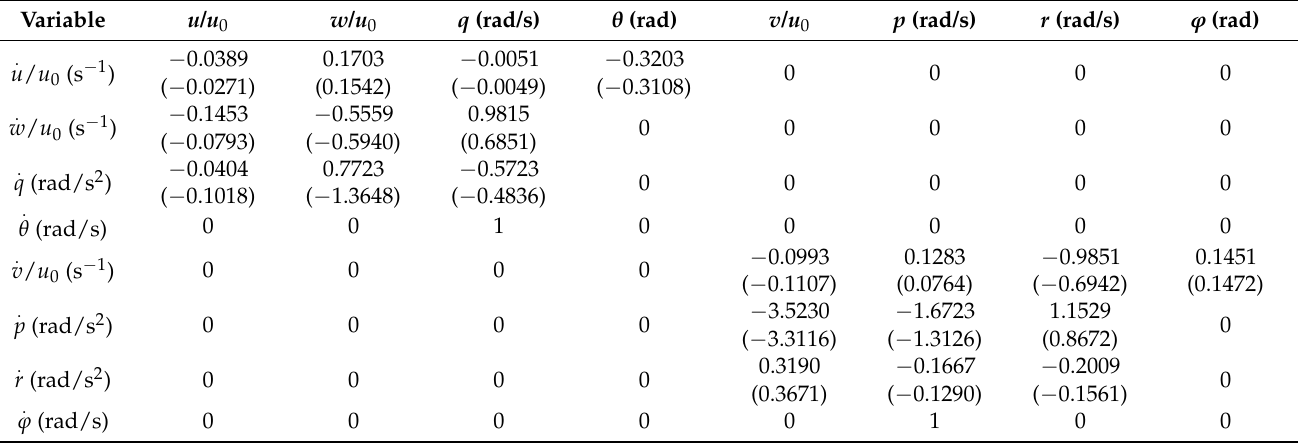
Table 28. CFD–RANS (extrapolated) 8 × 8 stability matrix for flight condition 22 in Tables 4 and 22 (reference takeoff